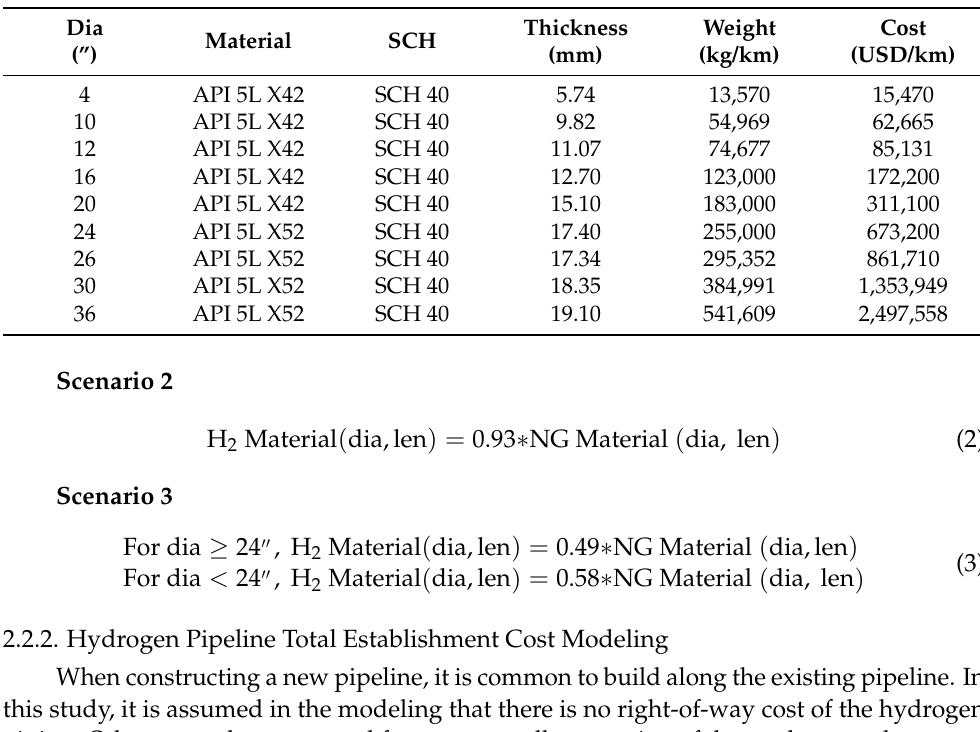
Table 4. Specifications of hydrogen pipelines based on Scenario